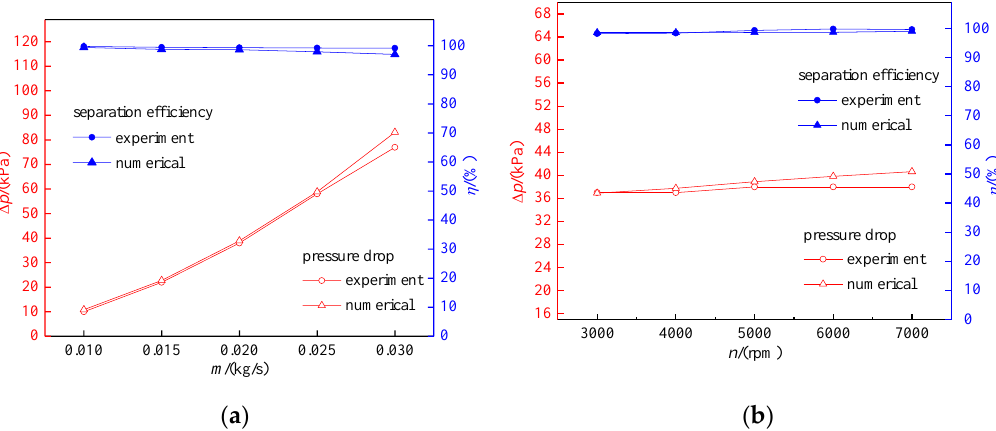
Figure 6. Two-phase model verification. ( a ) Ventilation rate; ( b ) rotating speed.